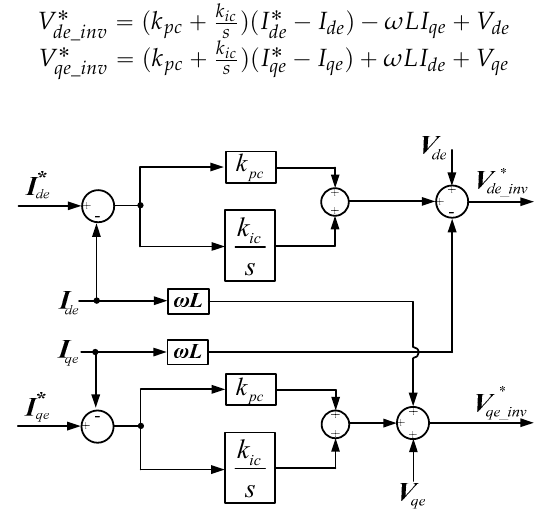
Figure 2. Current control block diagram.